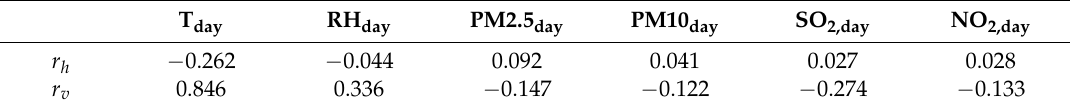
Table 1. The result of two-dimension correlation coefficient (TDC) analysis (day).